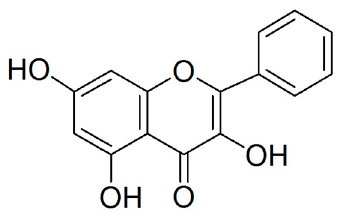
Figure 1. Structure of galangin.